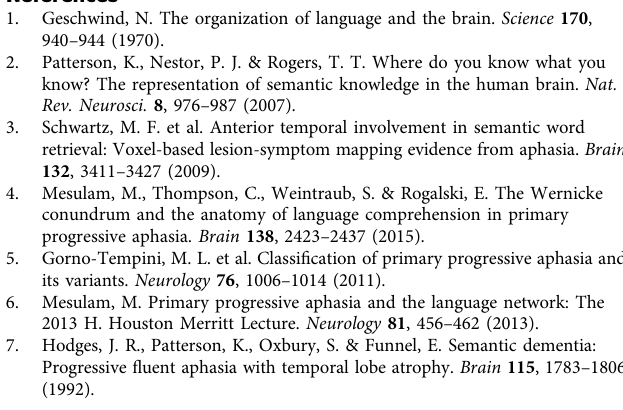
algorithm able to reconstruct kissing and crossing fi bers 57 . Motion and eddy- current correction of DTI data were implemented via the registration tool available